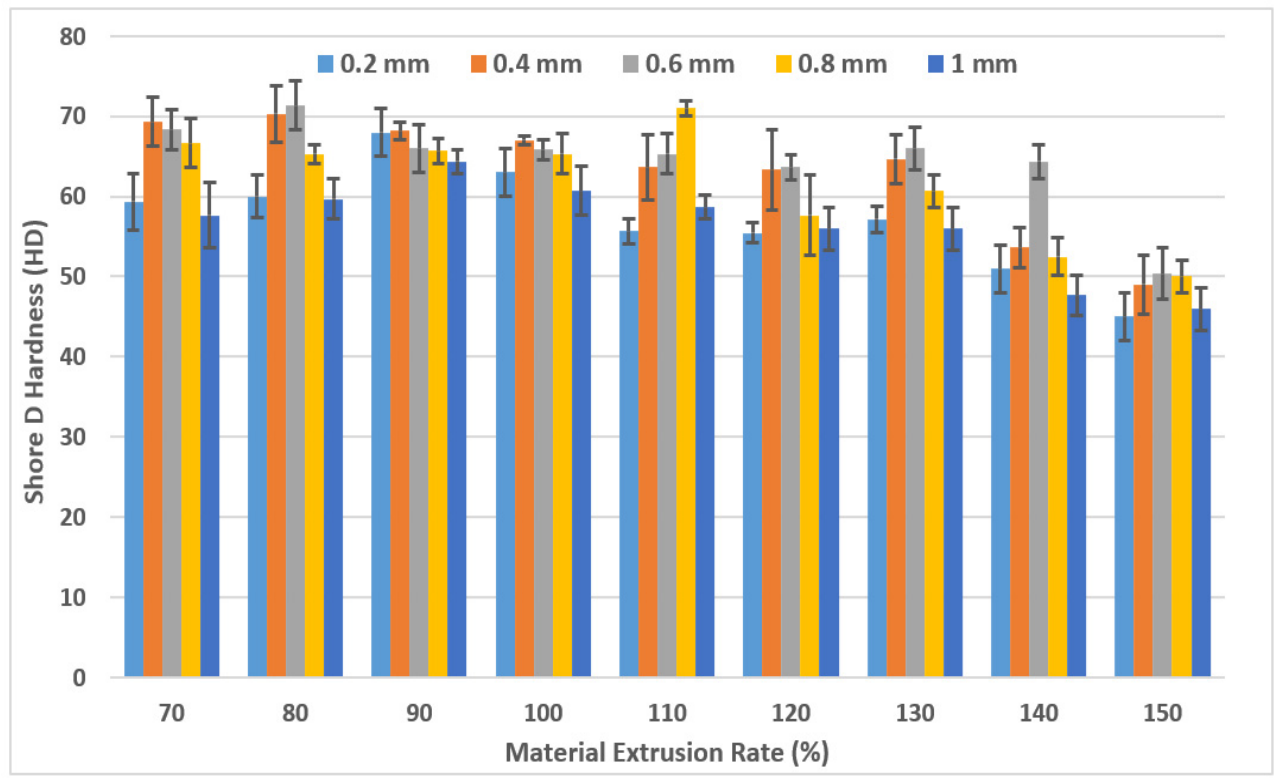
Figure 7. Results from indentation hardness testing.